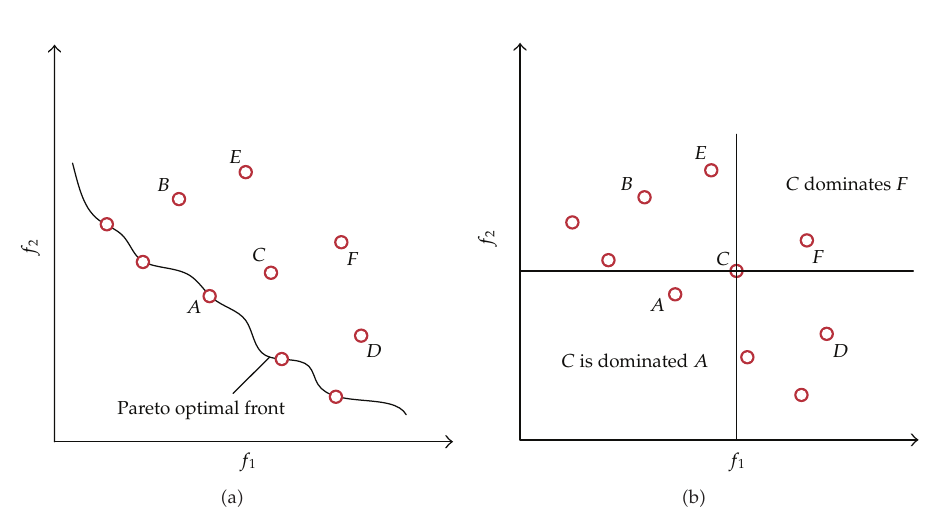
Figure 1: Illustrative example of Pareto optimality in objective space (cid:3) a (cid:4) and the possible relations of solutions in objective space (cid:3) b (cid:4)